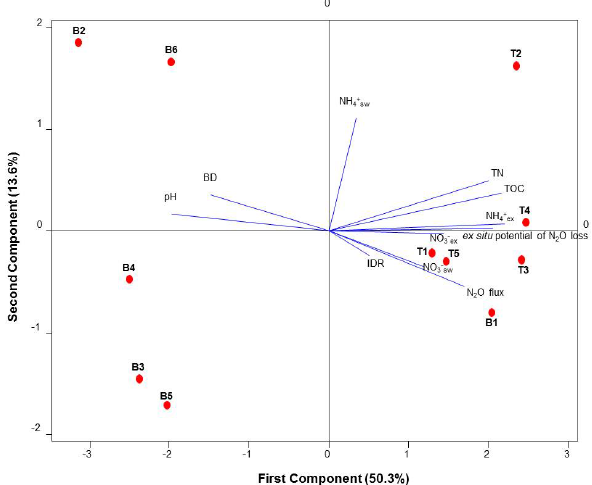
Fig. 8. Principal component analysis of cumulative N 2 O fluxes and soil parameters (Table 1) at TSP. Before analysis, the N 2 O flux and several of the parameters were transformed, whereas oth-